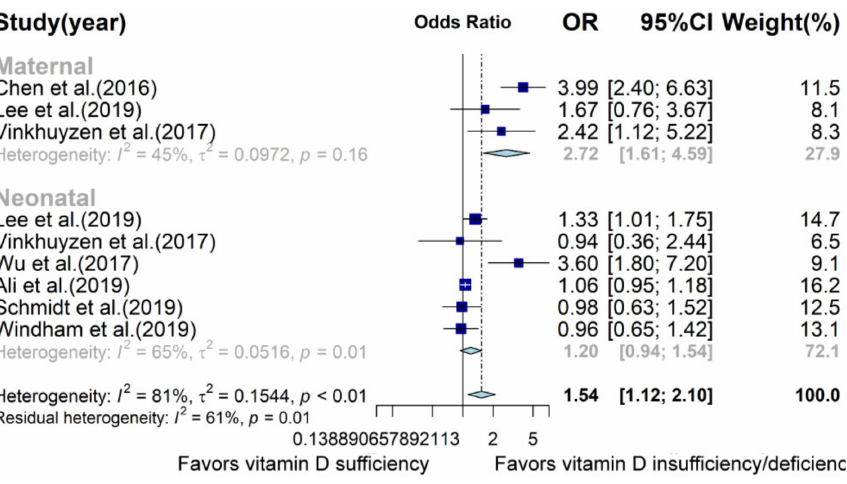
Figure 6. Forest plot of meta-analysis of nine prospective studies based on OR. Overall, children with lower maternal or neonatal vitamin D levels have a 54% higher chance to develop ASD, with 81% heterogeneity. OR, odds ratio; CI, confidence